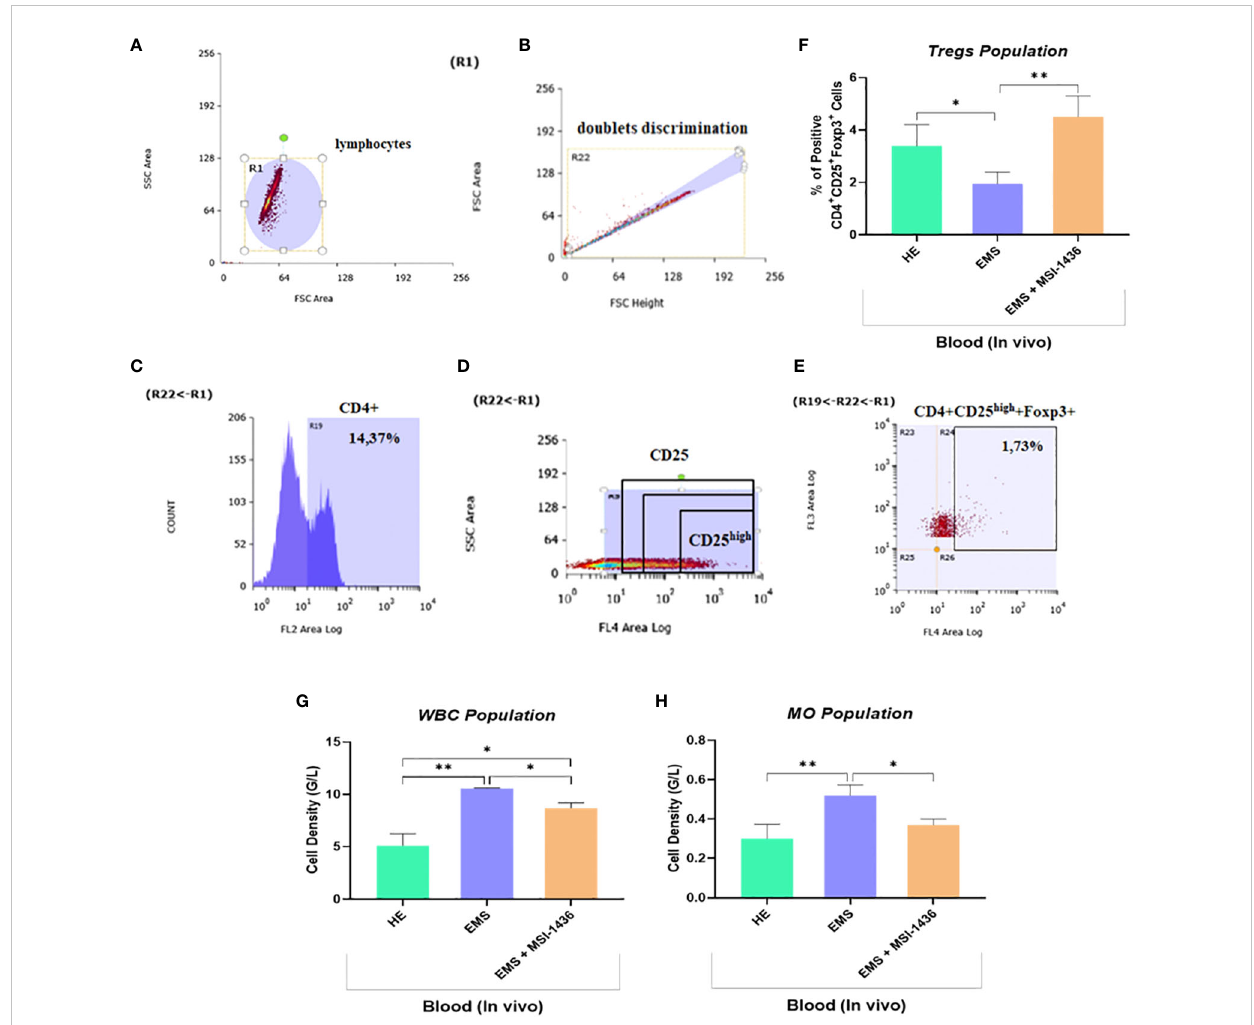
FIGURE 11 Effect of in vivo MSI-1436 treatment of in fl ammatory cells distribution in EMS horses. Gating strategy of the fl ow cytometry analysis of T cells in peripheral blood. R1 gate was set up around the cell population visible in the FSC/SSC axis (A) . The doublets were excluded from analysis by set up the gate R22 (B) . Gate R19 was set up on the cells positive to CD4 (C) . The division of CD25 on CD25 negative and positive (dim, medium and high) (D) . The percentage of the triple positive cells (CD4+CD25+Foxp3+) was established from set up the quadrants R24 (D) . Additionally, the percentage of the CD4+CD25high+Foxp3+ cells (Tregs) was established (E) . Average Tregs levels determined in each experimental group (F) . Total white blood cells (WBC) (G) and monocytes (MO) (H) densities obtained from the complete blood count analysis. Data are presented as a mean value obtained from measurments ± SD. Statistical signi fi cance was marked as follows: *p-value < 0.05 and **p <